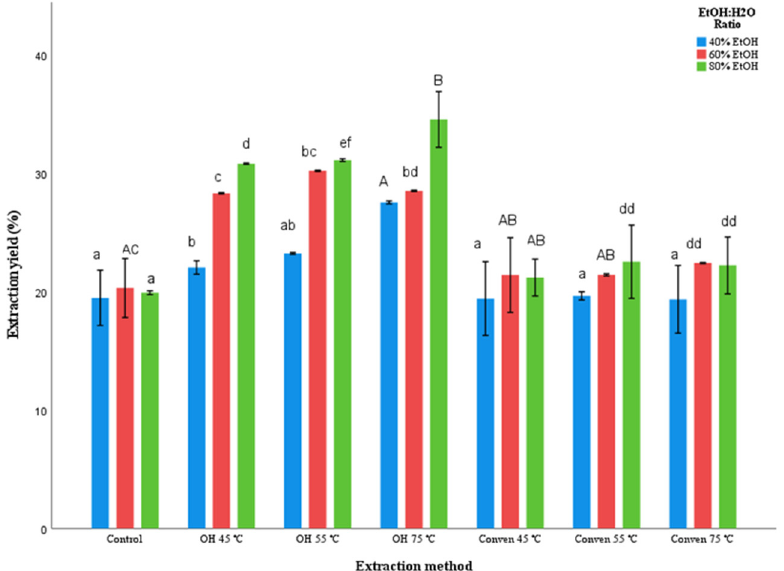
Figure 3. Extraction yield (g extract/100 g dry olive leaves) obtained through various extraction methods. The Control represents the extraction with no heat treatment (25 °C). The OH represents ohmic extraction using different concentrations of aqueous ethanol (40%, 60%, and 80% EtOH v/v ) and different temperatures (45 °C, 55 °C, and 75 °C), The Conven represents groups of samples with conventional heating extraction using the same solvent ratios/temperatures as those employed for OH samples. Mean values of % yield are shown with standard deviation error bars for each category of extraction method. Different letters (a–f, A–C) above the bars indicate statistically significant differences between means ( p < 0.05).